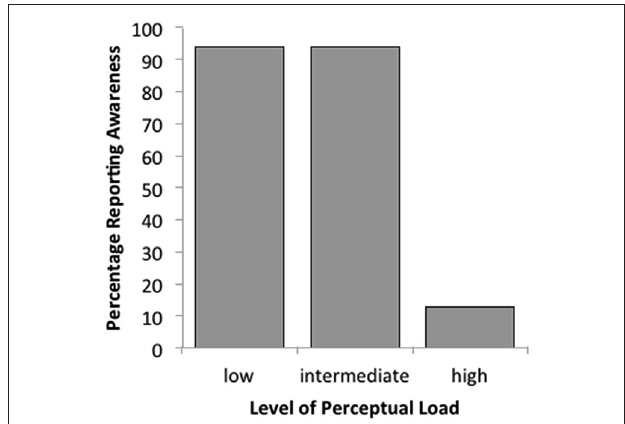
FIGURE 5 | Percentage of reported awareness of a peripheral critical stimulus (peripheral target) as a function of perceptual load (low vs. intermediate vs. high) in adults (Experiments 2 and 3)